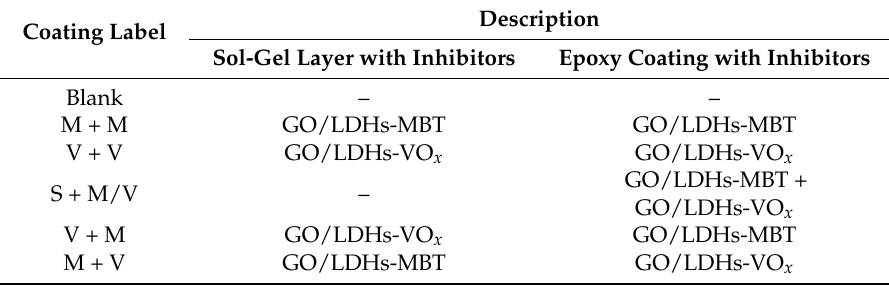
Table 1. Summary of the tested coating systems with various combinations of graphene oxide/layered double hydroxides-2-mercaptobenzothiazole (GO/LDHs-MBT) and graphene oxide/layered double hydroxides-vanadate (GO/LDHs-VO x